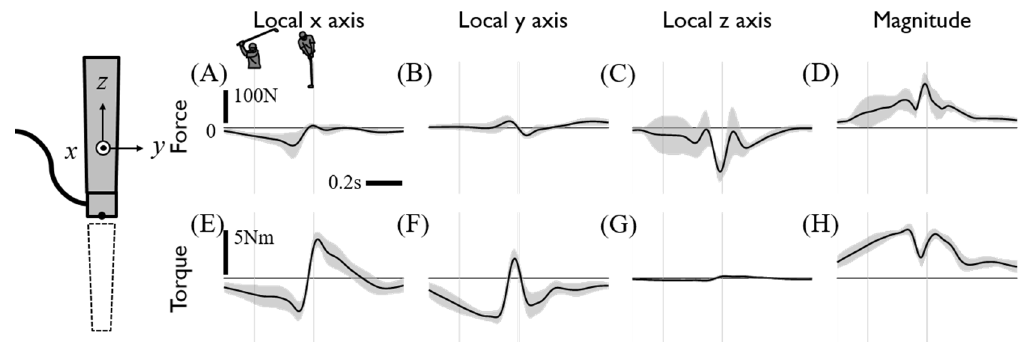
Figure 4. Internal grip force and torque. Each row shows force ( A – D ) and torque ( E – H ). Each column shows x , y , and, z values and the magnitude of force and torque at the club’s local coordinates. The force and torque act on the left-hand grip segment of the club at the sensing reference origin of the sensor and are averages of the driver swing data on all subjects. The two thin gray vertical lines indicate the backswing top and impact.